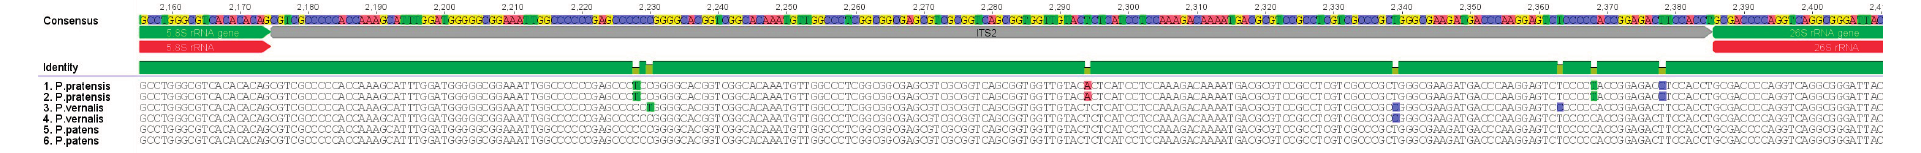
Figure 5. DNA alignment of the ITS2 region of the six studied specimens. The variation and species-specific mutation (SSM) in the nuclear ITS2 region enabled the molecular identification of the three studied